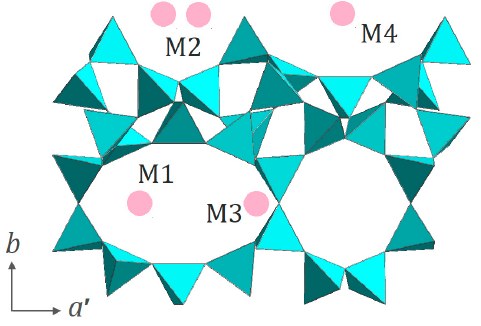
Figure 8. Cations sites M1, M2, M3 and M4 in A and B channels of clinoptilolite according to the Koyama and Takeuchi model [56] viewed along [001] ( a ’ = a sin β ).